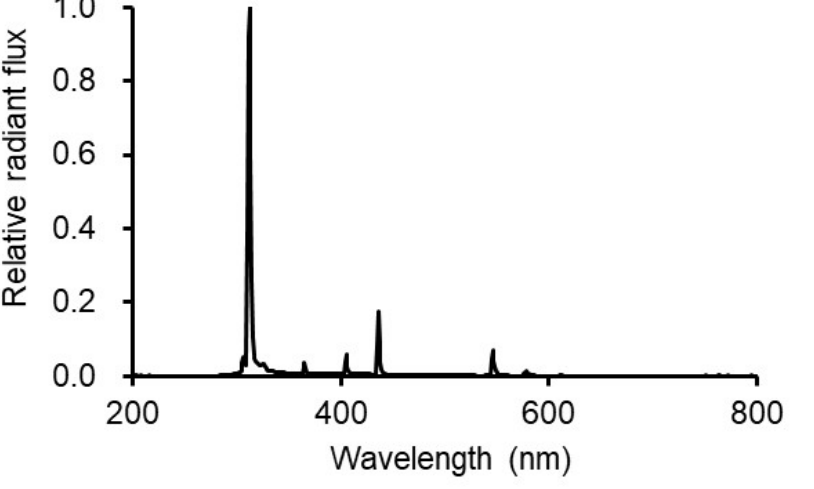
Figure 1. Spectral radiant flux of the UV-B lamps used in this study (TL20W/01 RS; Philips, Ham- burg, Germany).